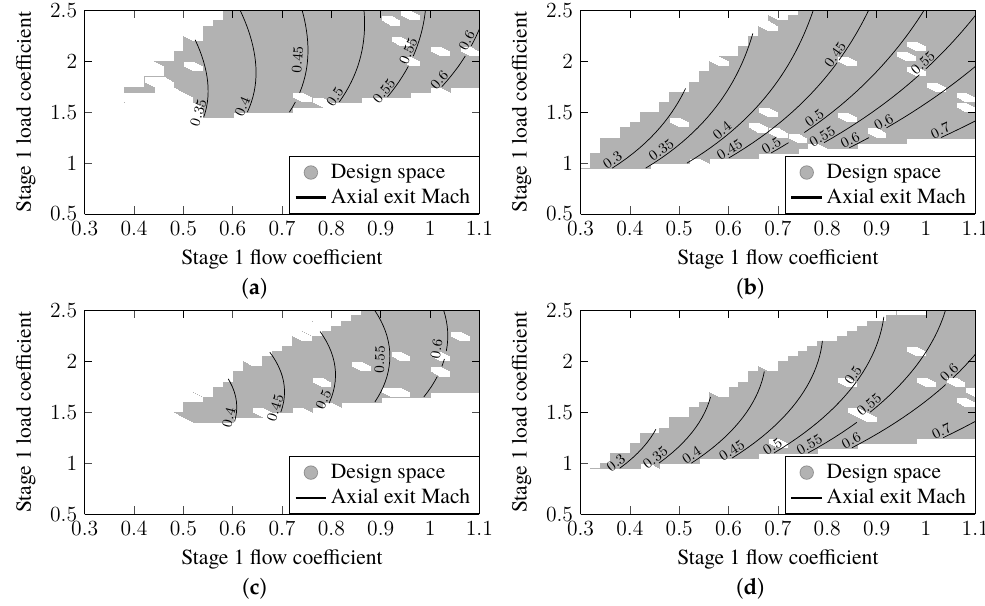
Figure 18. Comparison of the exit Mach numbers of low-pressure turbine design maps: ( a ) constant hub, two stages; ( b ) constant hub, three stages; ( c ) constant mean, two stages; ( d ) constant mean, three stages.